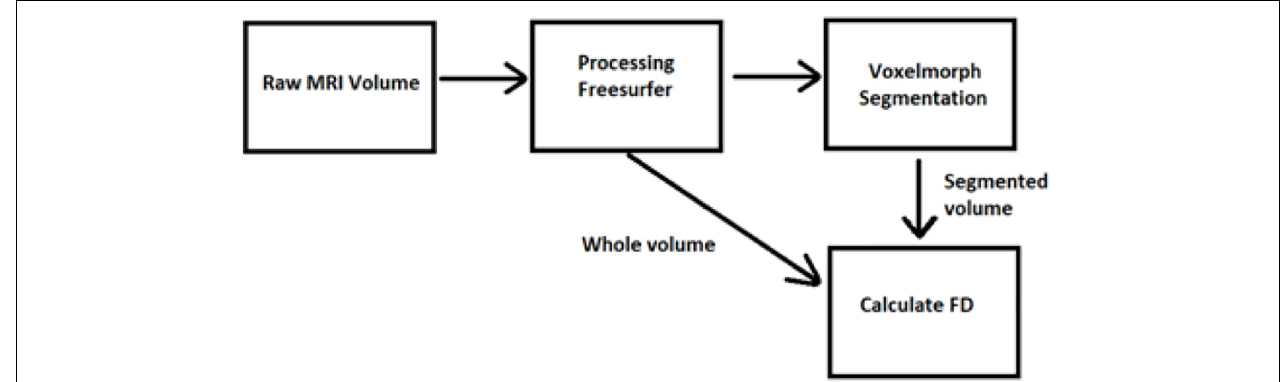
FIGURE 1 | The algorithm of the proposed method –